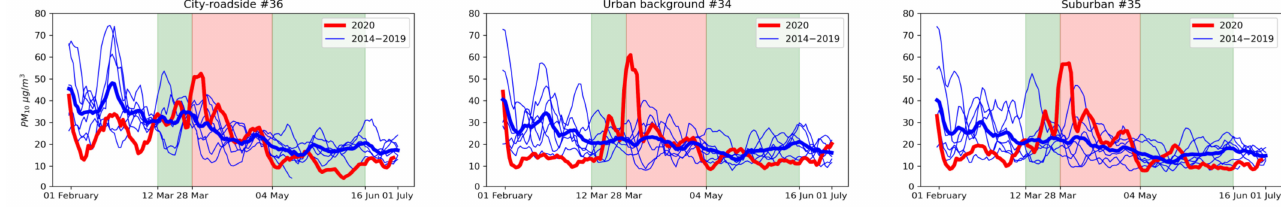
Figure 4. Daily mean air pollutant concentrations in February–June 2020 (red) compared to the same periods of 2014–2019 (blue) at three monitoring sites within the town of P é cs in Southern Hungary, 145,000 inhabitants (sites #34–36 in Figure 2.). Note the different scale for NO at the roadside location for better visibility. The public emergency period (green) and the curfew period (red) are marked with shaded